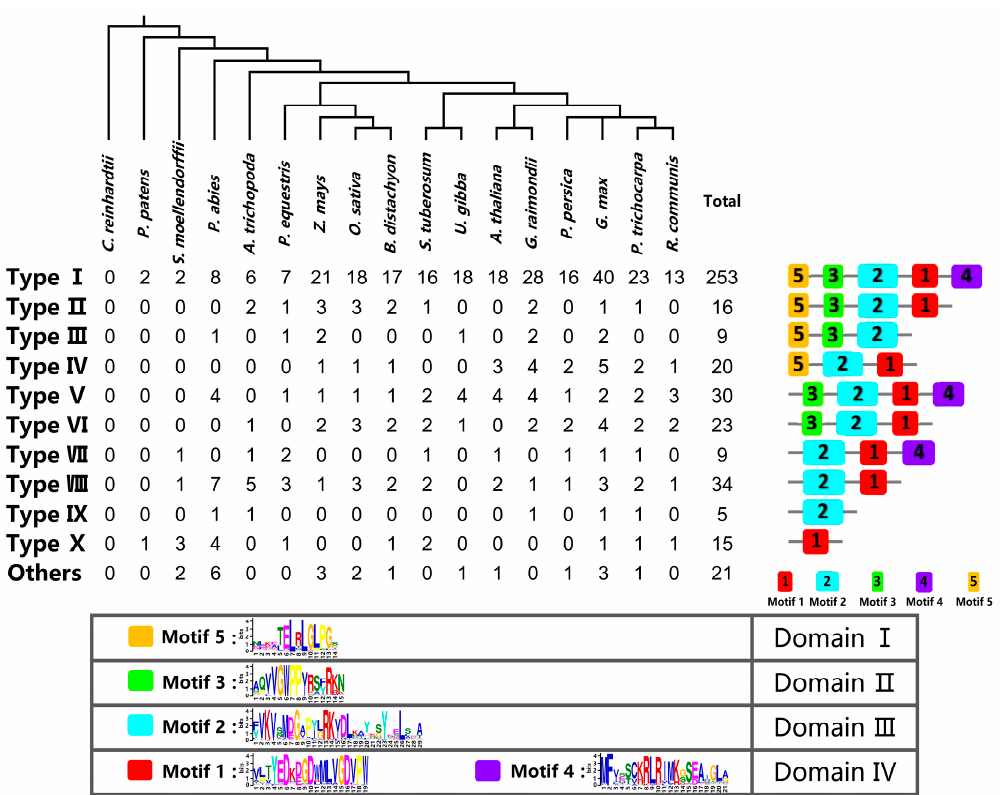
Figure 1. Graphical representation of 11 types of Aux/IAAs and their comparative analysis among the 17 plant species. The chart at the bottom shows the conserve amino acid composition of different motifs on average. The content of conservative amino acids is expressed by the height of characters. The phylogenetic tree at the top is from the Tree of Life Web Project (Available online: http://www.tolweb.org/Green_plants).